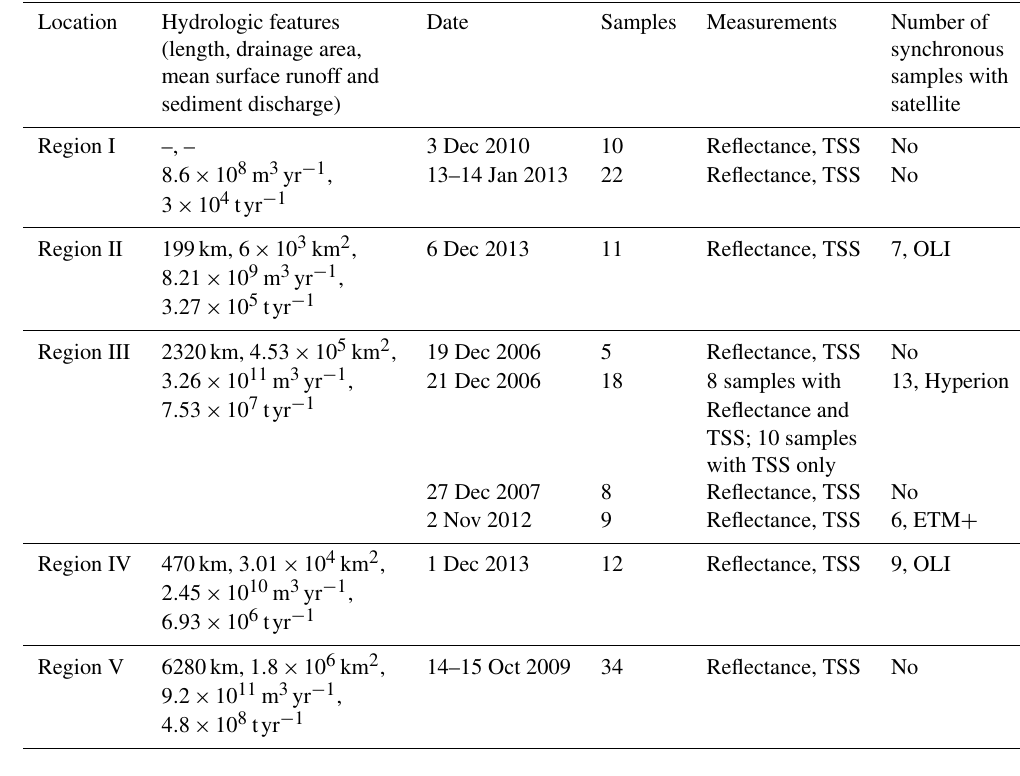
Table 1. Information about the study areas and in situ data. Location Hydrologic features Date Samples Measurements Number of